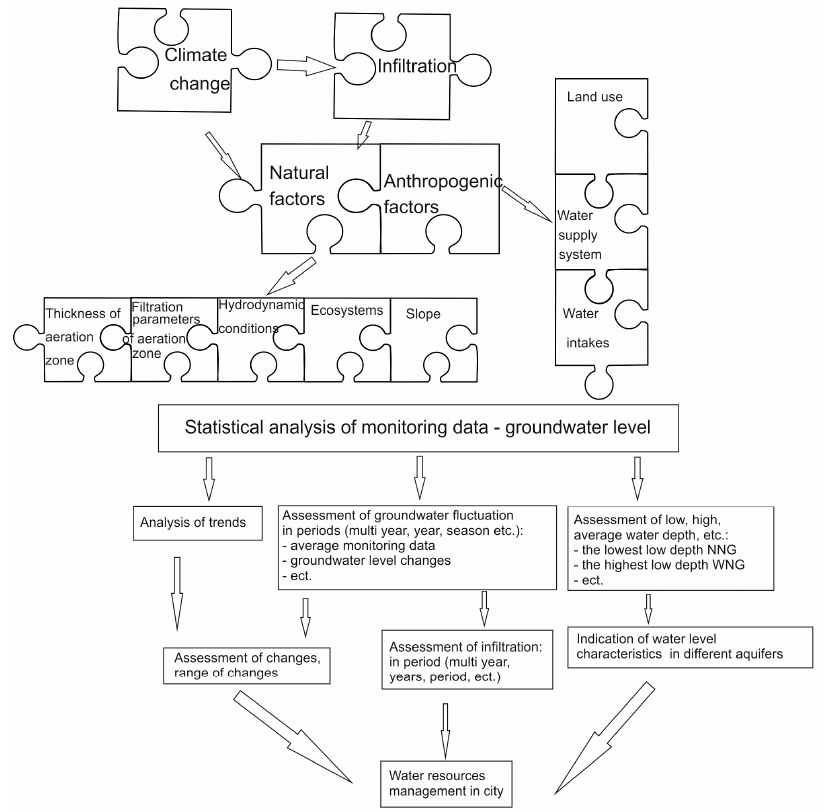
Figure 3. Factors and methods controlling groundwater infiltration and recharge in an urban area ([27], modified).